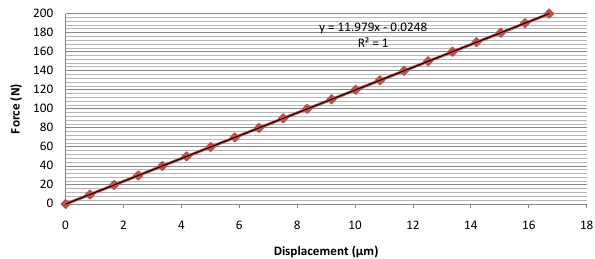
Figure 9. Sti ff ness experiment in Figure 9: Stiffness experiment in X axis